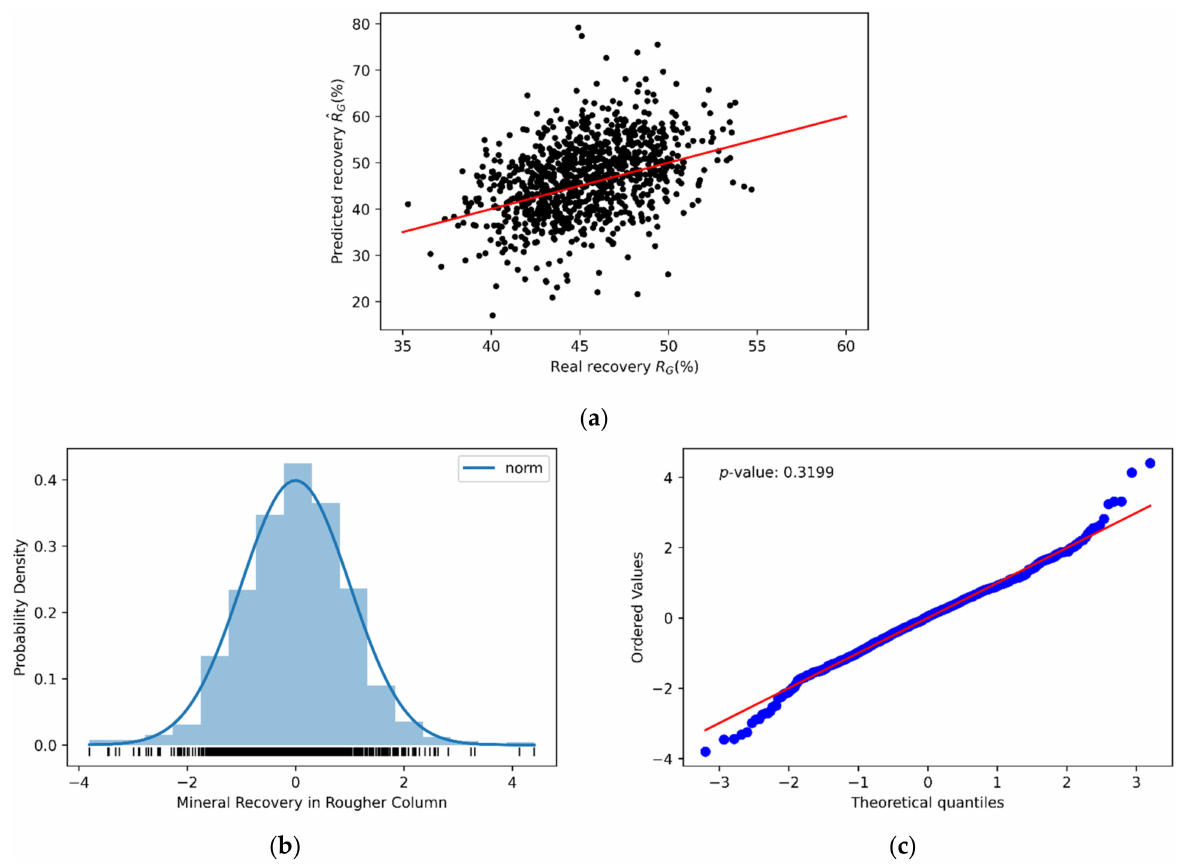
Figure 3. Contrast between the actual recovery and the prediction of the analytical models ( a ); distribution of normalized residuals ( b ); and normal probability distribution ( c